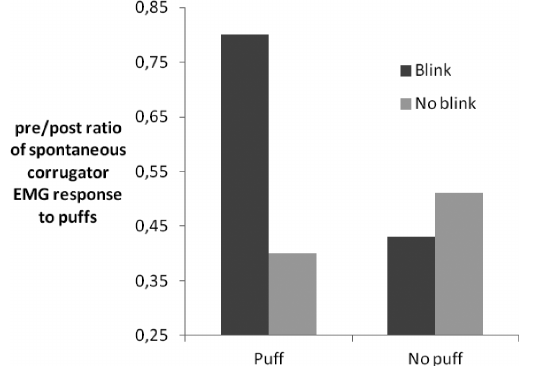
Fig. 3. Pretest to posttest ratio of corrugator EMG response to puffs (Blink re fl ex ratio).